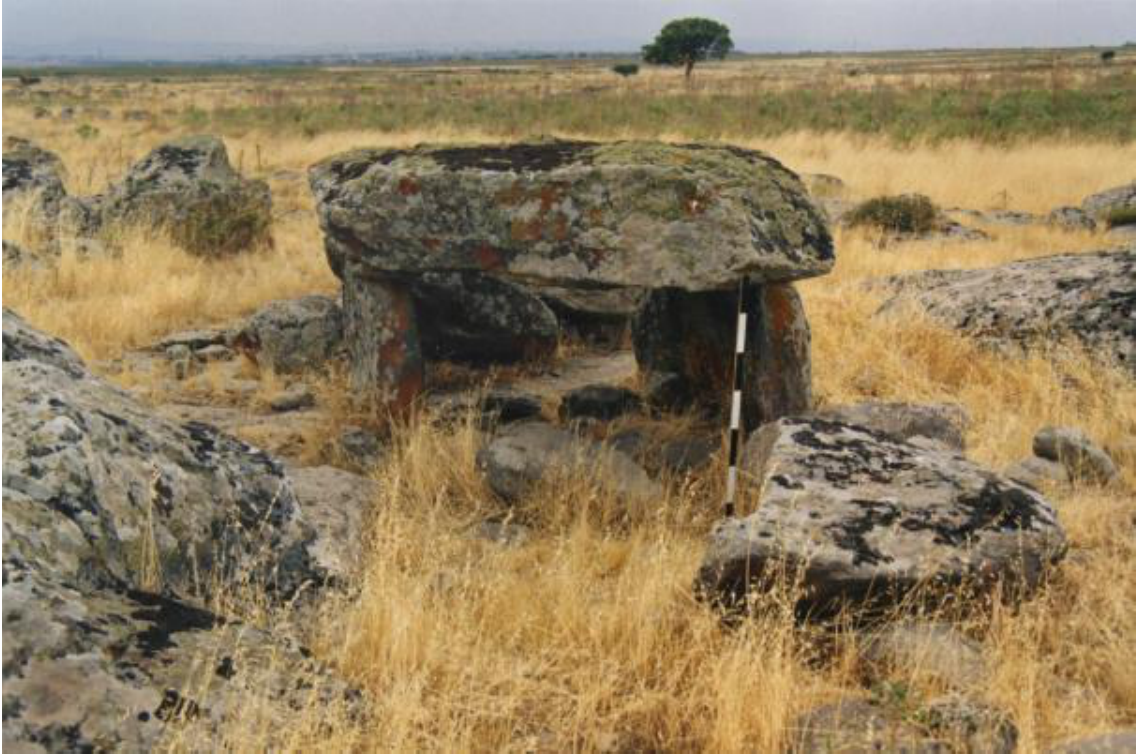
Figure 2. Dolmen Terra Tenera-Macomer. In the background is the plateau of Campeda (photo by R. Cicilloni). The Planargia is limited to the west by the sea and to the south by the Riu Mannu